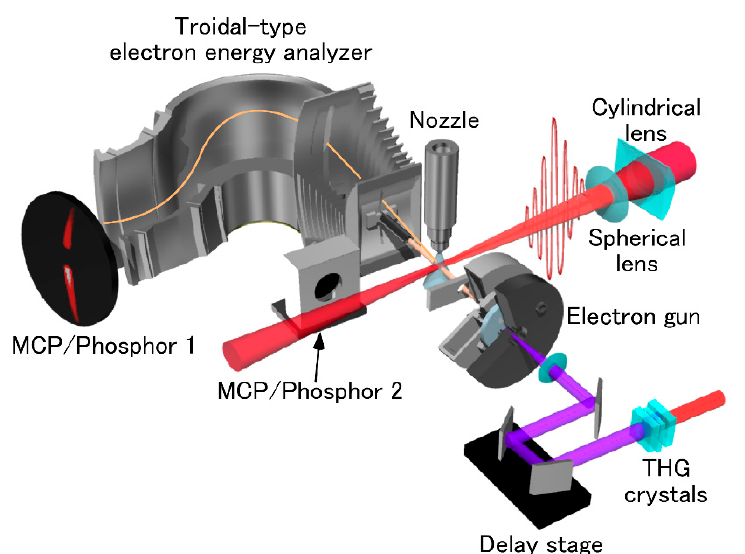
Figure 1. The schematic of the experimental setup of LAES [63]. Reproduced from Kanya, R.; Morimoto, Y.; Yamanouchi, K. “Apparatus for laser-assisted electron scattering in femtosecond intense laser fields.” Rev. Sci. Instrum. 2011 , 82 , 123105, with the permission of AIP Publishing. By taking the leading term of the Bessel functions in Equation (1) or Equation (3), intensities of the LAES signals in BFA and KWA become approximately proportional to Δ t ( λ 4 I ) | n | . This means that